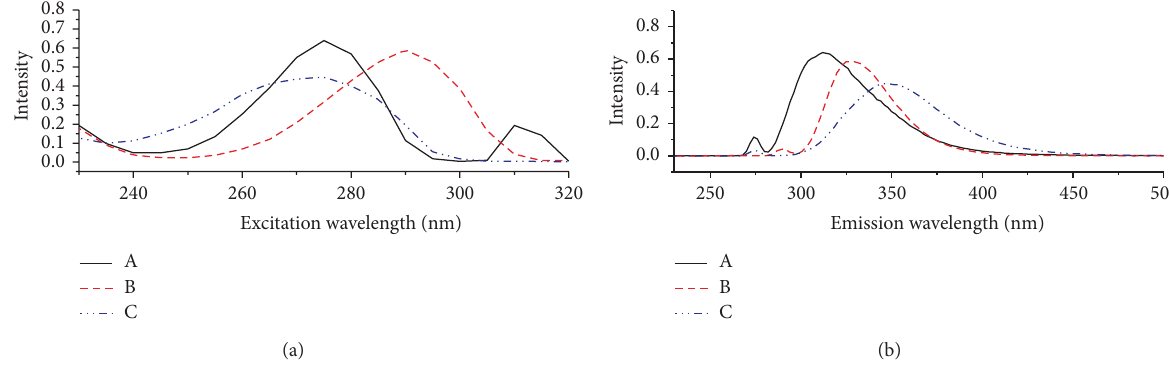
Figure 3: The excitation and emission profiles of samples of three pure components of